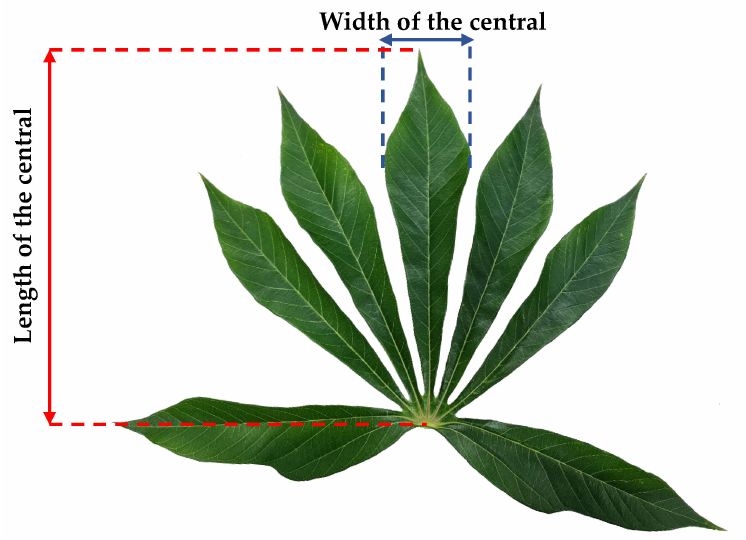
Figure 1. Demonstration measurement of the length and width of the central lobe of cassava. Ten plants for each genotype were harvested at 12 MAP. The harvested plants were separated into individual organs, including leaves, petiole, stem, root, and storage